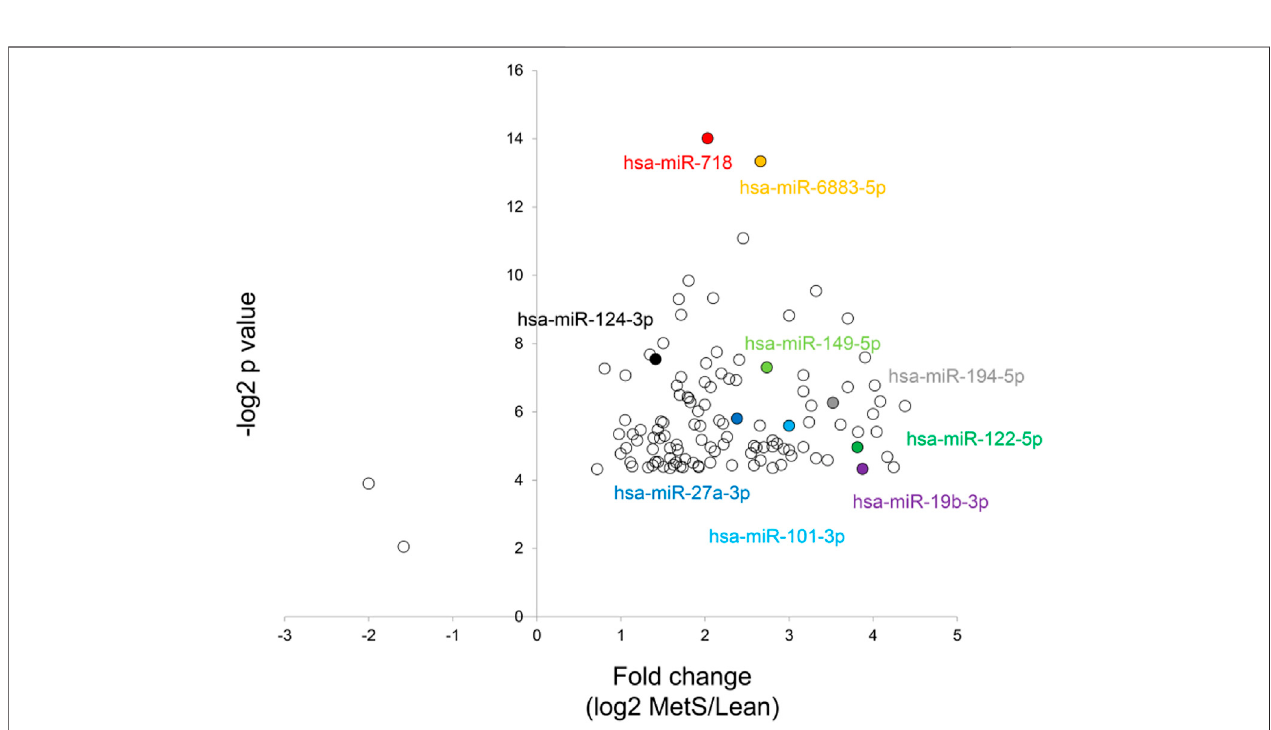
FIGURE 3 | Volcano plot of differentially expressed miRNAs in circulating MetS-EVs versus Lean-EVs.